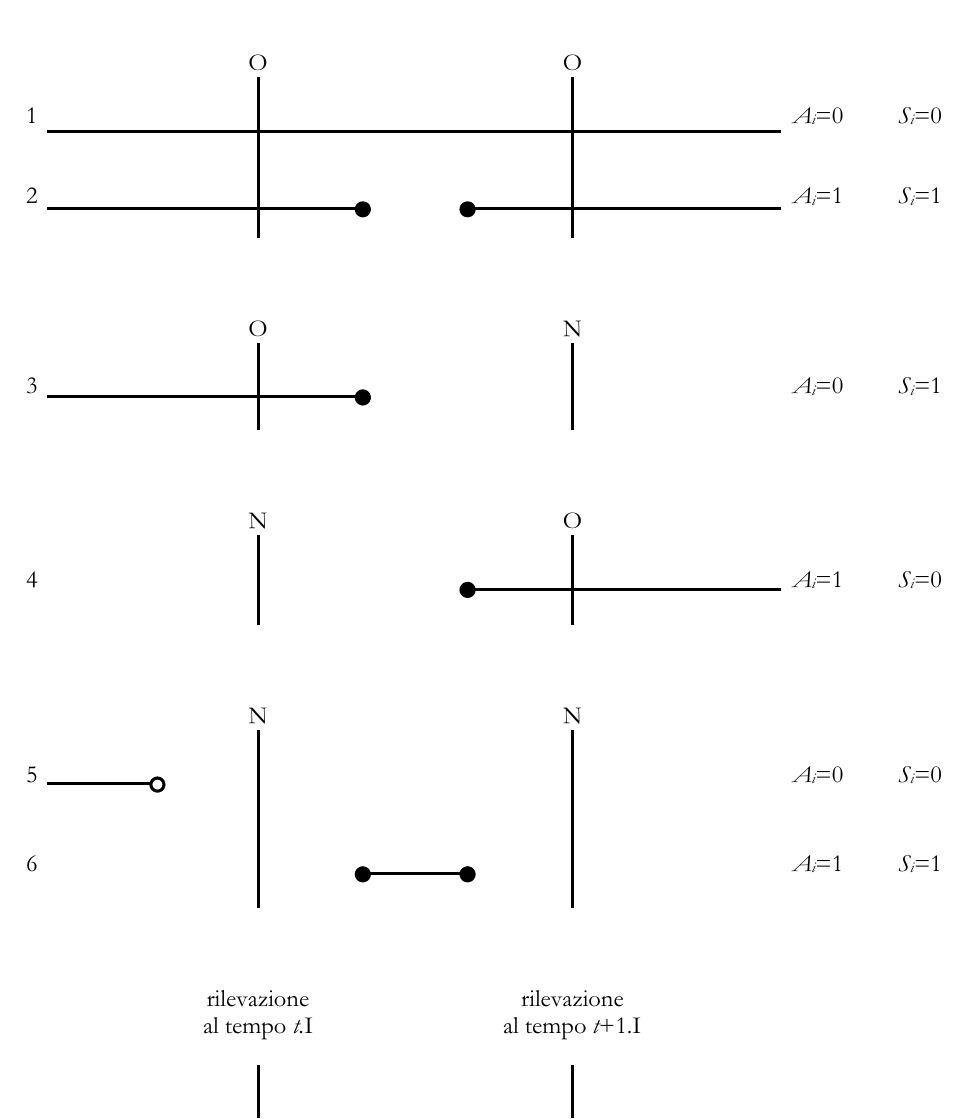
Figura 1 – Schema per l’identificazione degli episodi lavorativi e delle transizioni dall’abbinamento a due